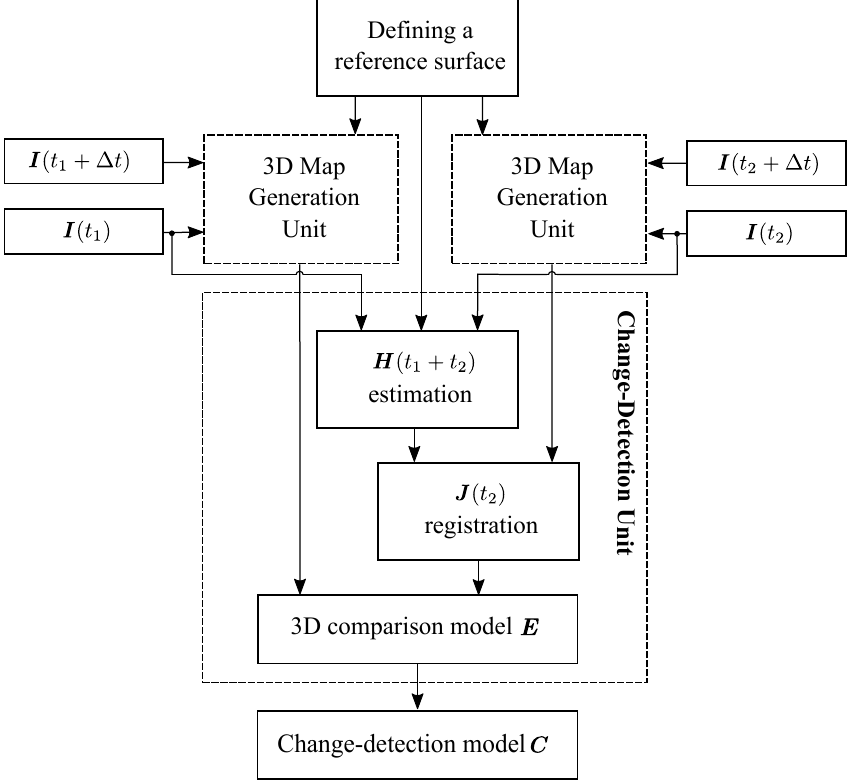
Figure 5. The 3D comparison and change detection models based on the 3D feature